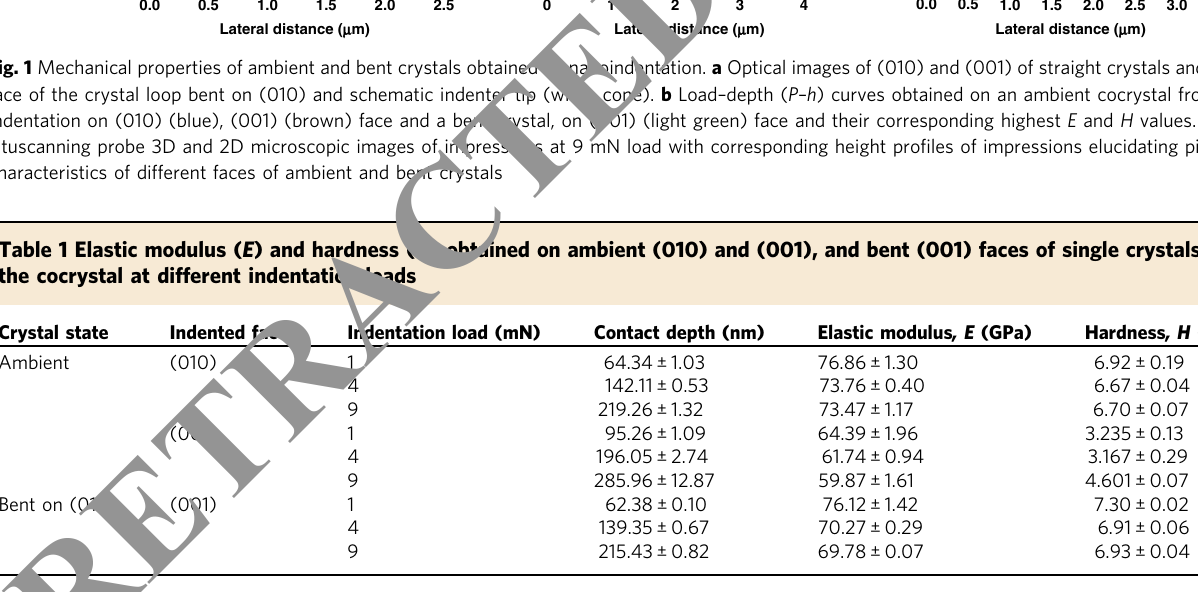
Table 1 Elastic modulus ( E ) and hardness ( H ) obtained on ambient (010) and (001), and bent (001) faces of single crystals of the cocrystal at different indentation